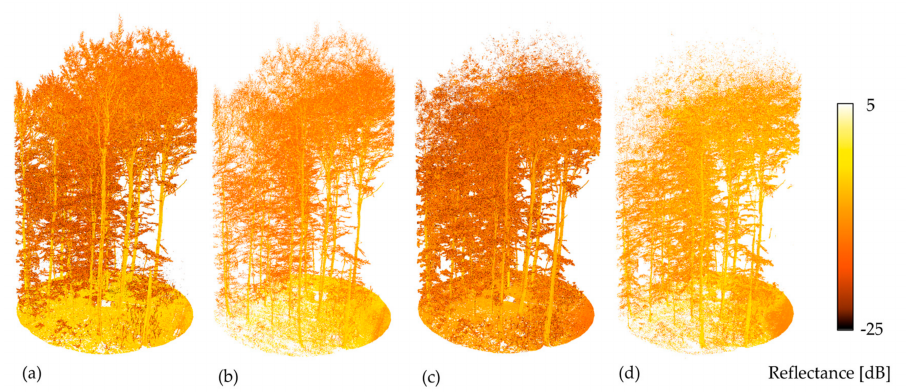
Figure 3. Point cloud of sample plot 1 with color coded reflectance in dB defined by the scanner